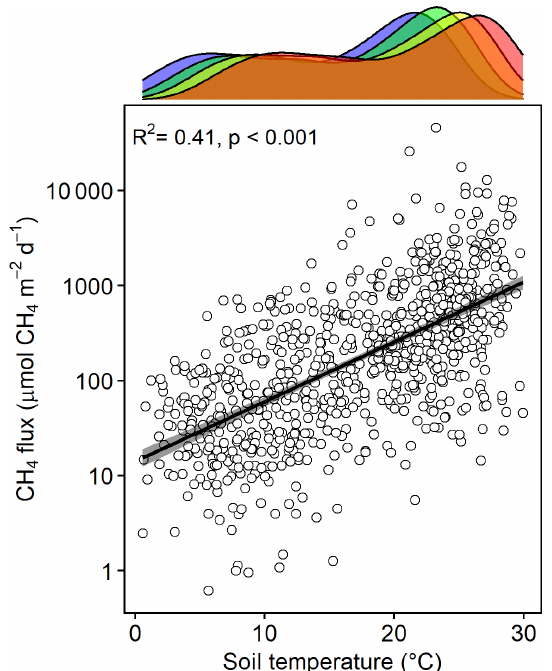
Figure 1. Bottom: CH 4 emissions from each plot versus the soil temperature at the time of measurement. Top: density plot depicting the range of soil temperatures in each treatment, delineated by color: ambient (blue), + 1.7 (green), + 3.4 (yellow), and + 5.1 ◦ C (red).